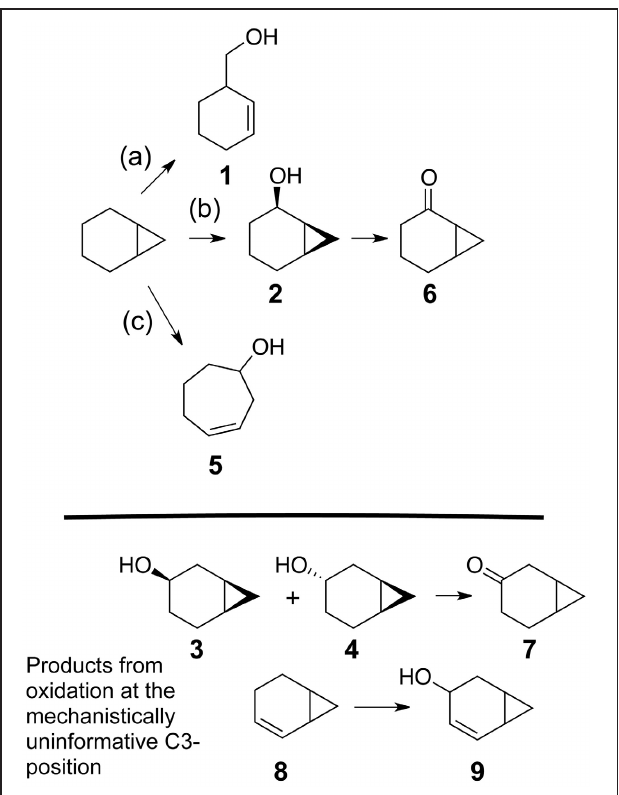
FIGURE 3 | Possible products from the oxidation of norcarane. (a) radical pathway (b) insertion pathway or pathway of short lived radical (c) cationic pathway. 1–9 represent specific compounds that can be formed from the oxidation of norcarane.